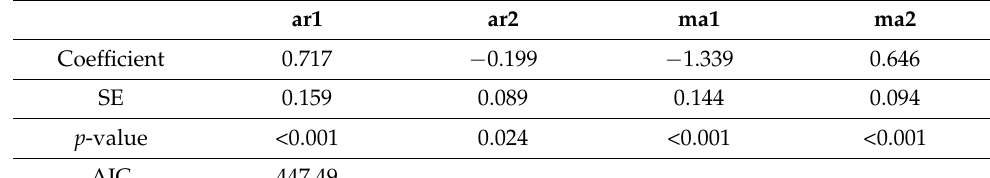
Table 3. Optimal ARIMA (2,1,2) model for stationary confirmed cases.